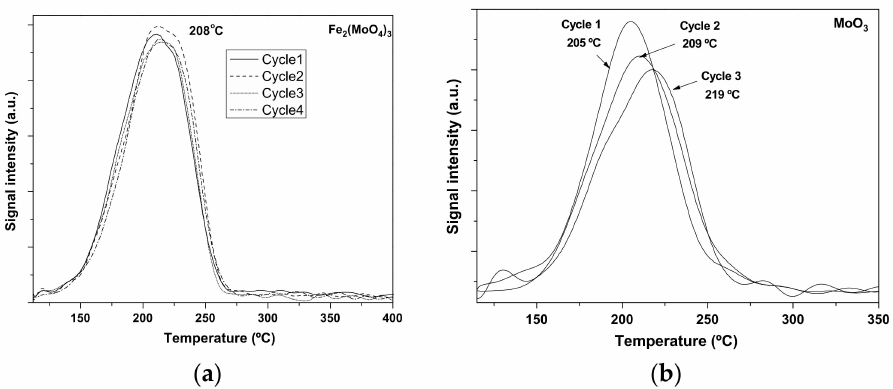
Figure 9. Cyclic CH 2 O/CH 3 OH-TPSR spectra with no oxidation between TPSR experiments for ( a ) bulk Fe 2 (MoO 4 ) 3 catalyst Mo/Fe = 1.5 and ( b ) bulk MoO 3 catalyst. Reprinted from [29] Copyright © (2010) with permission from